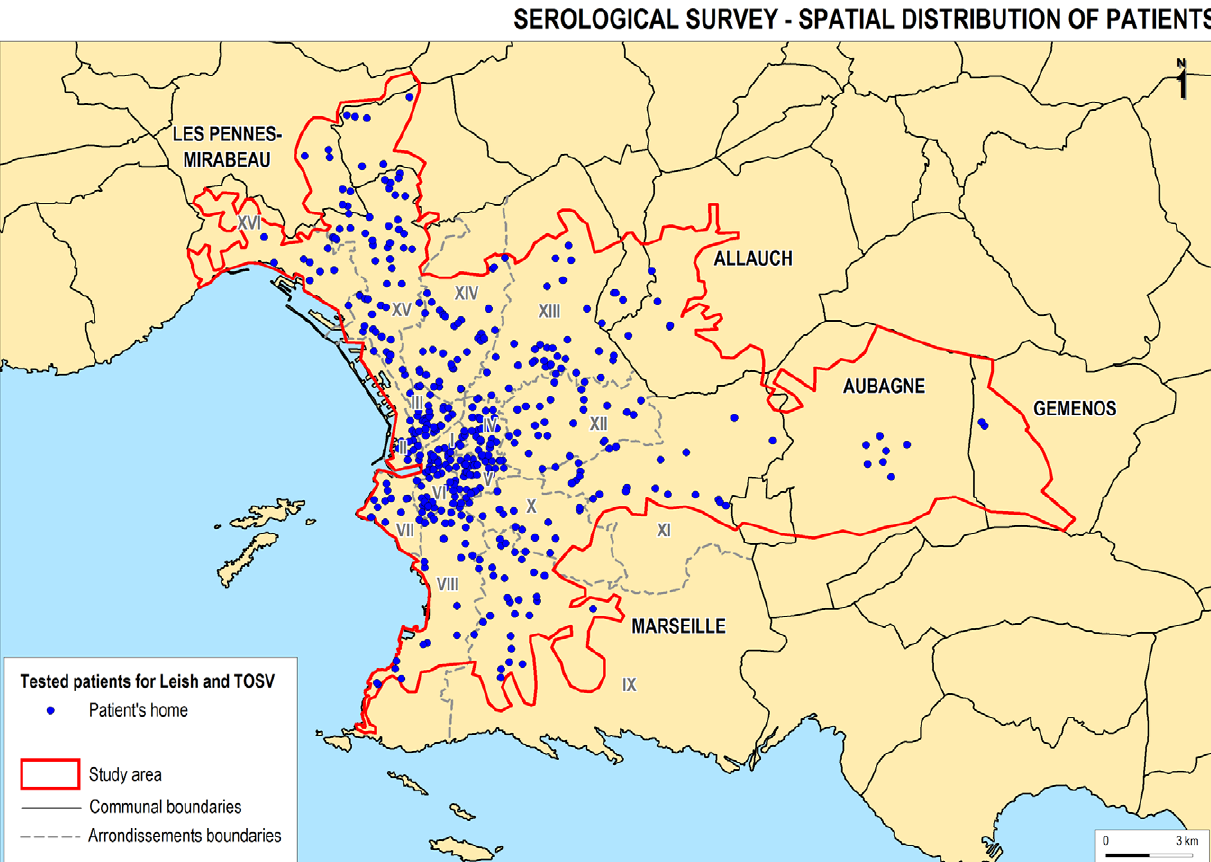
Figure 2. Spatial distribution of individuals tested in this study. Each point corresponds to a postal address. The distribution of the selected sample was found to follow the population density.